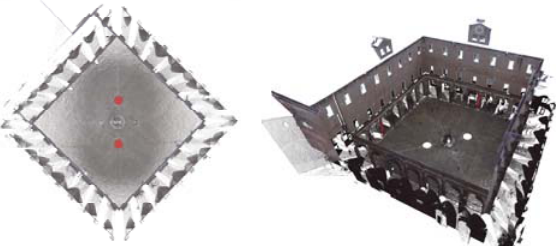
Figure 6. The laser scanning point cloud with the scans’ position highlighted.